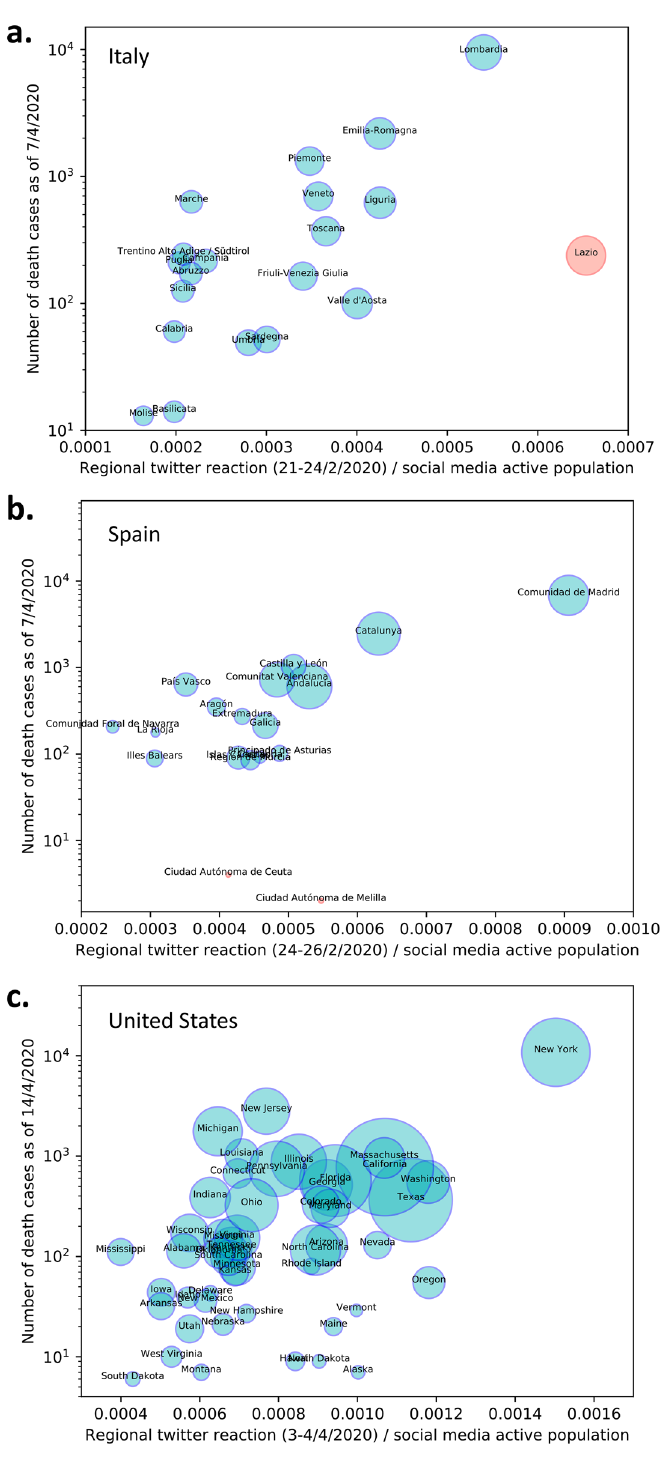
Figure 3. Demonstration that the reaction on social media can correctly detect and rank the epidemic’s impact on different regions one month ahead. The y-axis reports the cumulative number of deaths one month forward and the x-axis reports mean tweet intensity at the initial attention peak per geopolitical region of: ( a ) Italy; ( b ) Spain and ( c ) United States. The diameters of the circles are proportional to the population of the